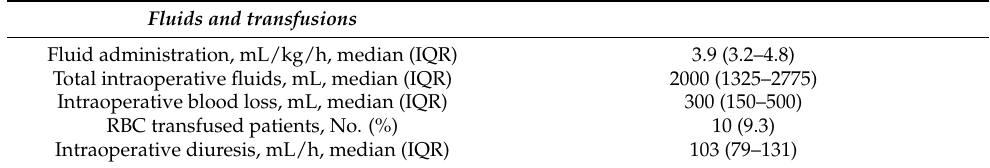
Table 2. Fluid balance and biochemical and hemodynamic parameters in the 108 investigated